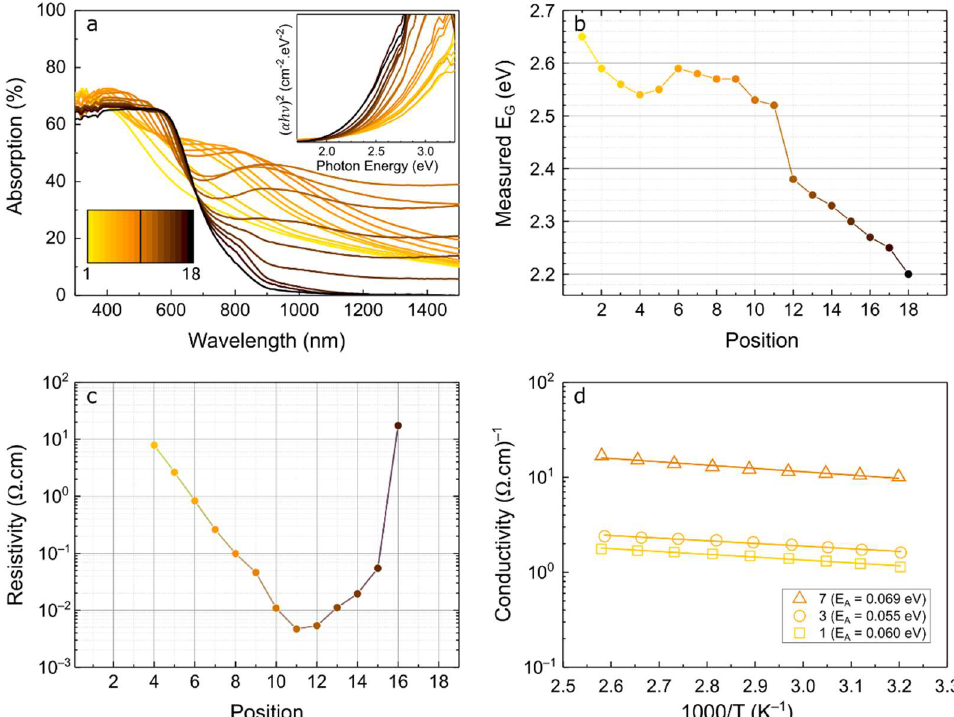
Figure 4. ( a ) Absorption spectra of the 18 positions calculated from the measured transmission and reflection results, by A = 100%–T–R. Inset with Tauc plot of each position, calculated for direct bandgap semiconductors; ( b ) Bandgap calculated for each position in the substrate; ( c ) Resistivity values across the 18 positions; ( d ) Temperature dependence of the conductivity of positions 1, 3 and 7, and respective activation energies given by the slope of the linear fits, represented by solid lines. Position 1 and 18 are the furthest from and closest to the Cu target, respectively.